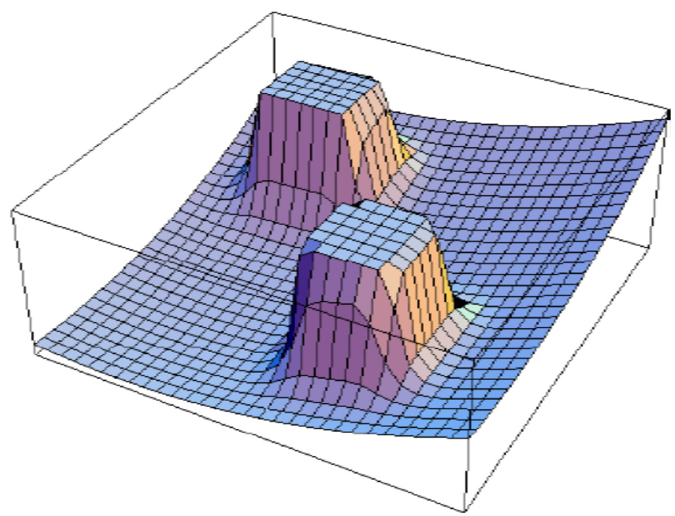
Figure 7. Three-dimensional diagram of artificial potential field obstacle avoidance.